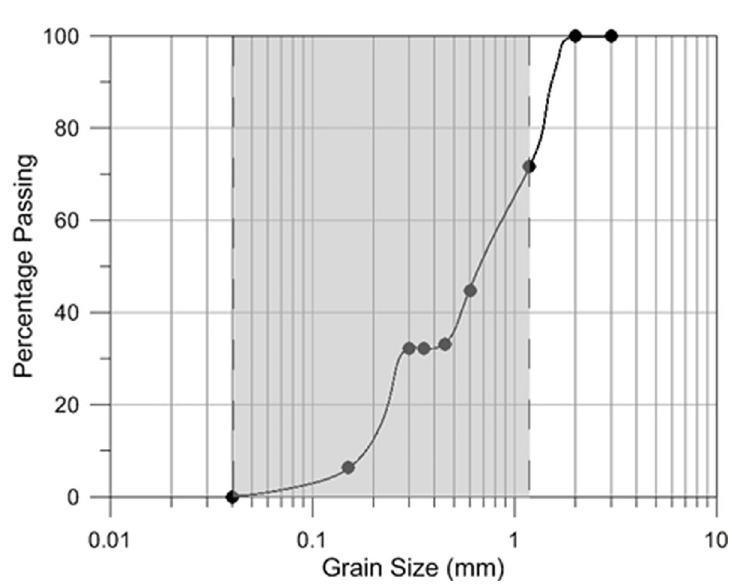
Fig 1. Sand particle size distribution. The size distribution utilised for the experiment is